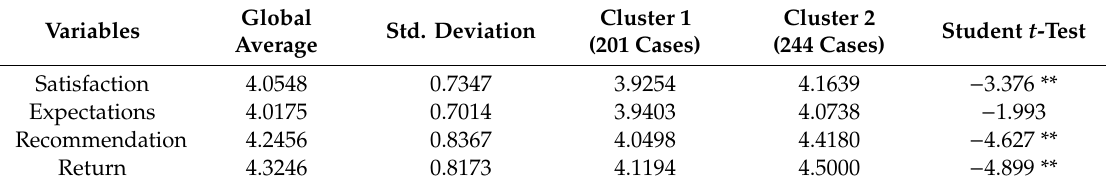
Table 6. Di ff erences per cluster in